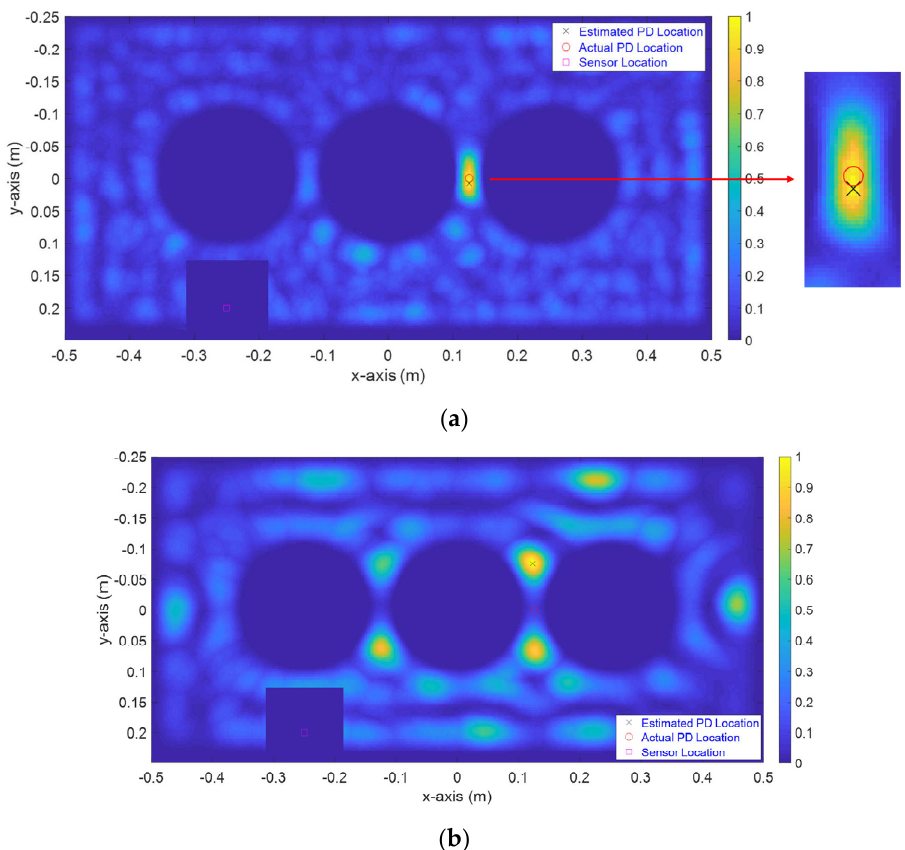
Figure 7. The distribution of normalized maximum electric field power over the complete simula- tion time interval on the computational domain, ( a ) obtained by the EMIF method with a 2.5 mm localization error and ( b ) obtained by the EMTR method with a 75.0 mm localization error. In this case study, the EMTR method cannot localize the source between two adjacent metallic objects.